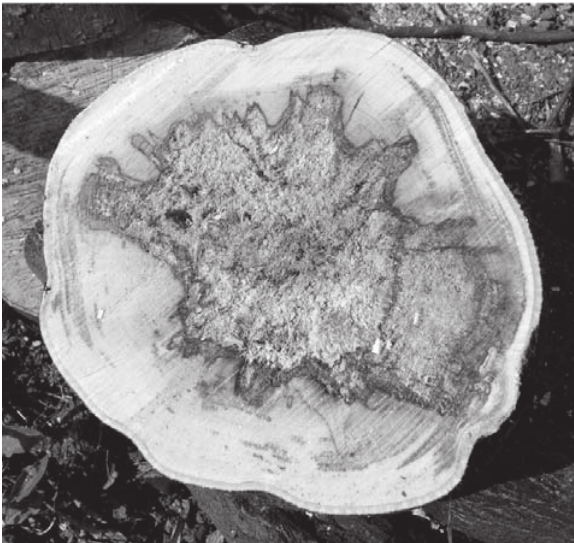
Fig. 1. Cross-section of orange-tree trunk infected with Fomitiporia mediterranea . Light-colored decay in the center, surrounded by brown hard necrosis.